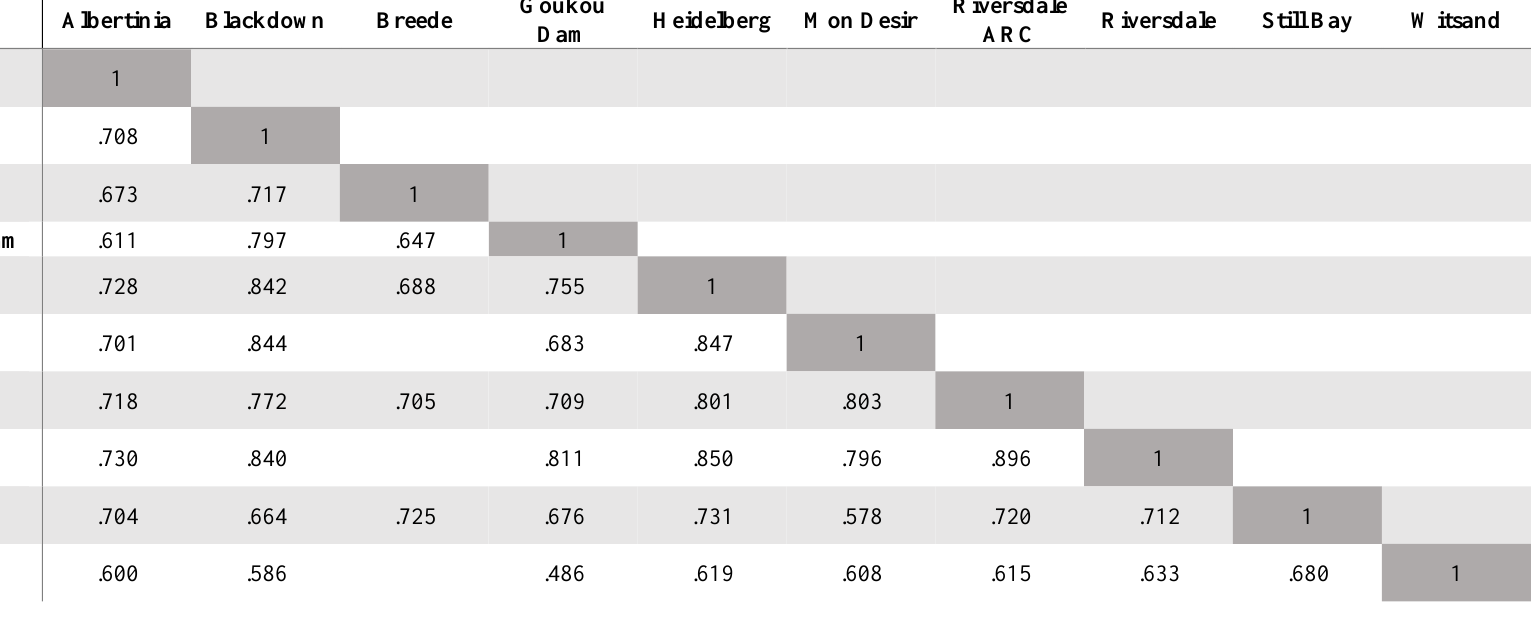
Table A3.2: Spearman’s rank correlation for rainfall recorded at official weather stations of the South African Weather Service (SAWS) and Agriculture Research Council (ARC) (all correlation is significant at the 0.01 level